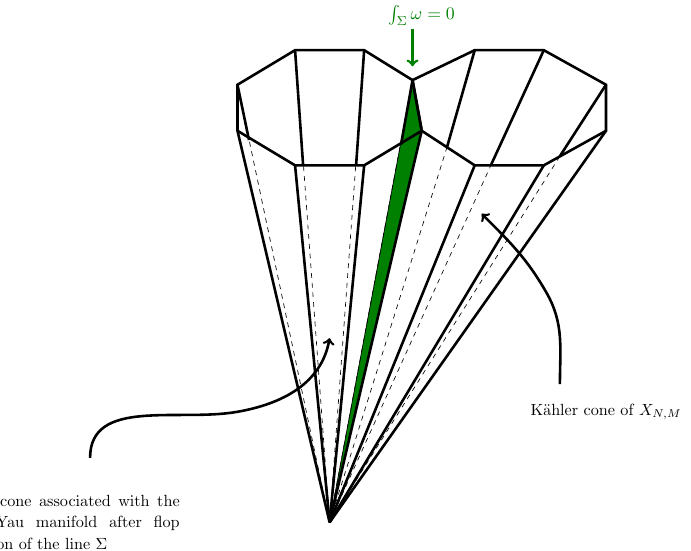
Figure 2 . K(cid:127)ahler cones of two Calabi-Yau manifolds connected through a (cid:13)op transition of the curve (cid:6).The corresponding wall, along which the cones are glued together, is characterised by R ! = 0 and is shown in (cid:6)